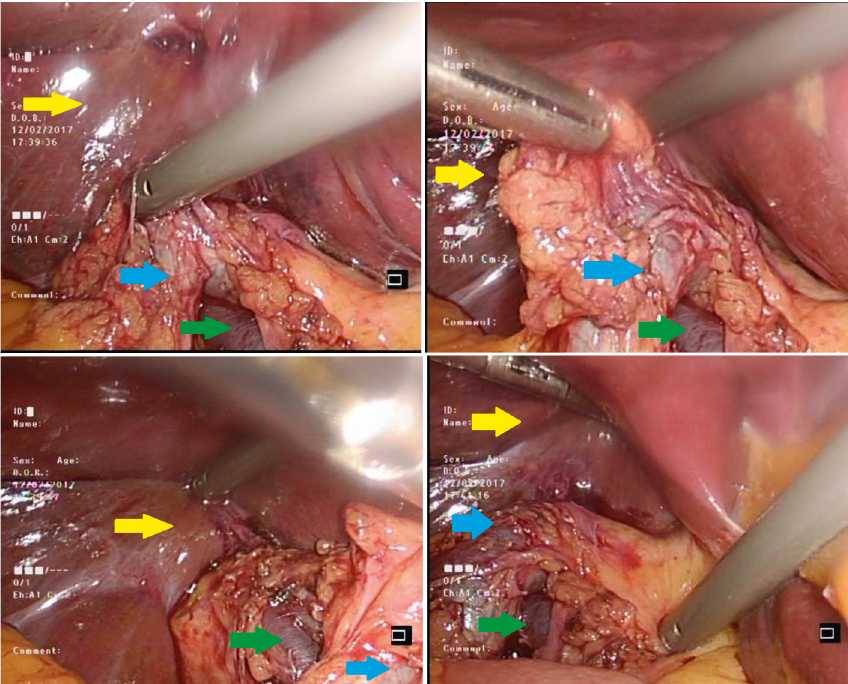
Figure 2: Intraoperative figures demonstrating liver (yellow arrow), common bile duct (blue arrow), and portal vein (green